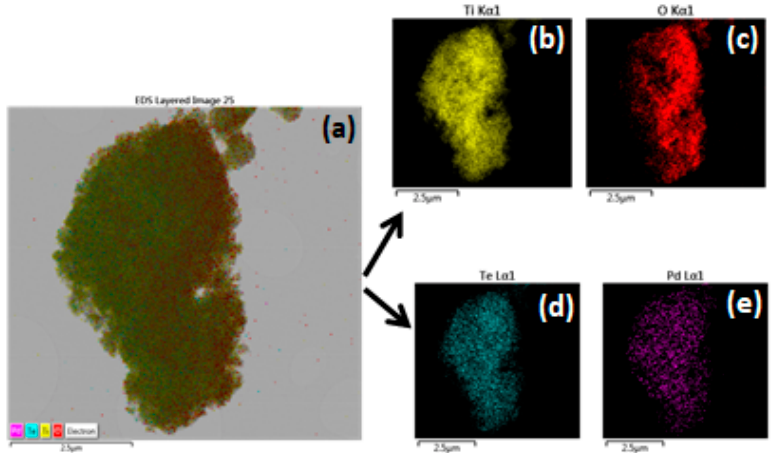
Figure 7. ( a ) Integral XEDS-STEM composition map from selected area of sample 90TiO 2 /10TeO 2 /Pd heat treated at 600 °C; ( b ) composition map of Ti; ( c ) composition map of O; ( d ) composition map of Te; ( e ) composition map of Pd. Table 2. Elemental analysis according to TEM.